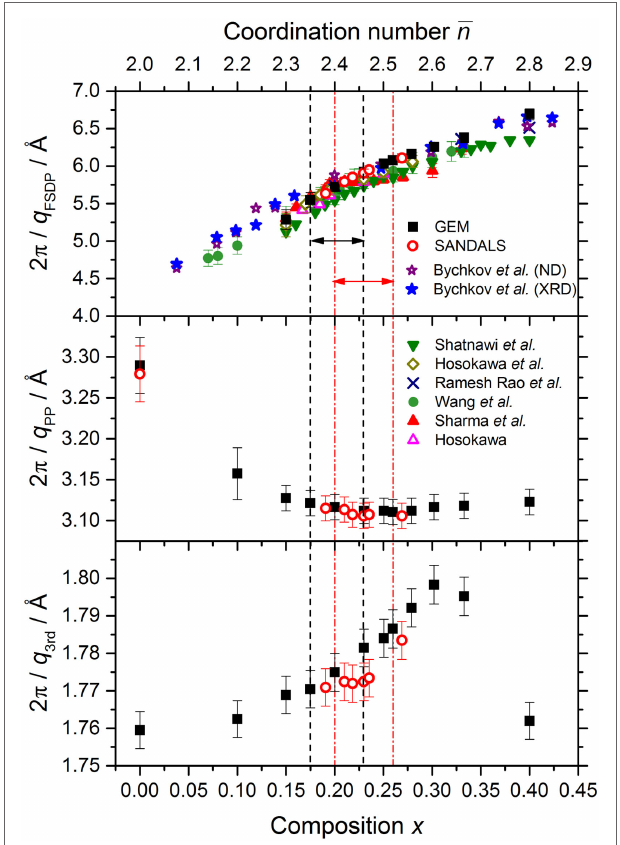
FIGURE 7 | The dependence of the periodicity 2 (cid:25) / q i associated with the FSDP, principal peak (PP) and third peak in S ( q ) on the composition x and mean coordination number ¯ n = 2 ( 1 + x ) . The results from the present neutron diffraction (ND) work were obtained using either the GEM or SANDALS diffractometer. In the case of the FSDP, these results are compared to those obtained from the ND and high energy X-ray diffraction (XRD) work of Bychkov et al. (2005); the high energy XRD work of Shatnawi et al. (2008); the ND work of Ramesh Rao et al. (1998); the XRD work of Sharma et al. (2005) and Wang et al. (2004); and the anomalous X-ray scattering work of Hosokawa (2001) and Hosokawa et al. (2003). The pairs of vertical dashed (black) or chained (red) lines, and associated horizonal arrows, mark compositions for which ∆ H nr ≃ 0 as found in the present work or in the work of Boolchand et al. (2001a), respectively.